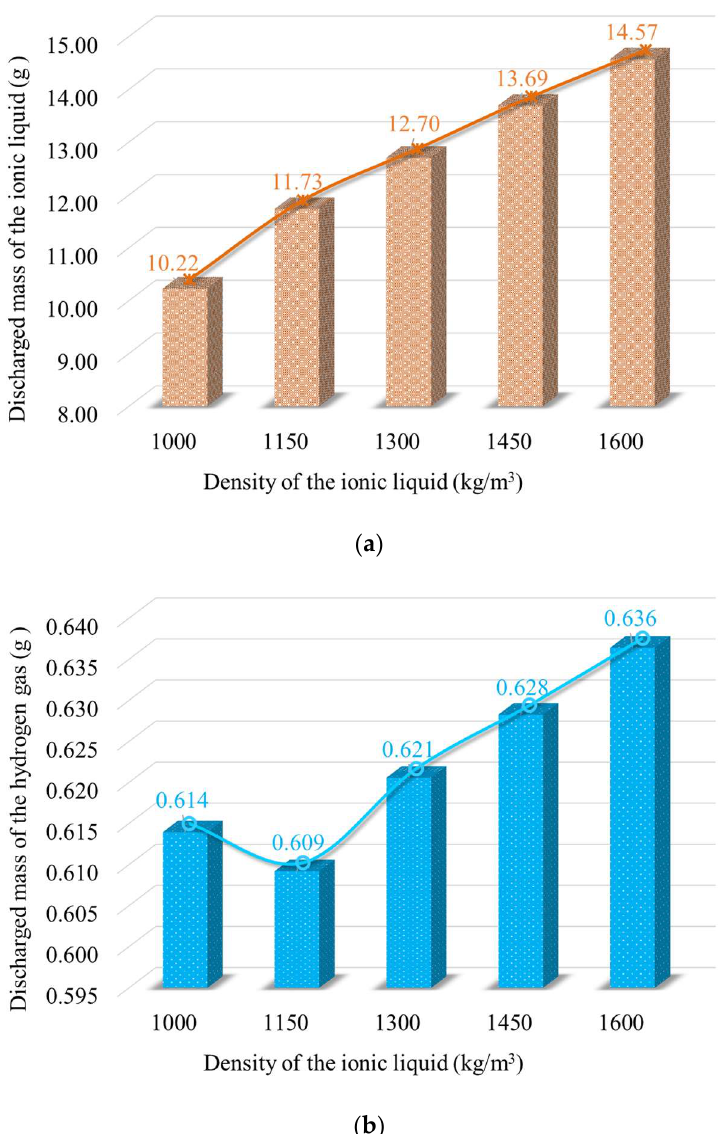
Figure 9. Mass transfer of ( a ) the ionic liquid and ( b ) hydrogen gas after one operation cycle. The total turbulent kinetic energy with different densities of the ionic liquid in one operation cycle is provided in Figure 10. The turbulent kinetic energy is the mean kinetic energy per unit mass associated with eddies in a turbulent flow, and the total turbulent kinetic energy is the turbulent kinetic energy multiplied by the total mass of the fluids. A decrease in the total turbulent kinetic energy was found from 0.000 to 0.025 s, while an elevation in it was found from 0.025 to 0.075 s in all simulation cases. From 0.075 to 0.160 s, a general reduction in the total turbulent kinetic energy was revealed with small fluctuations when it was close to 0.160 s. The largest peak value was found as 0.61 kJ with a liquid density of 1000 kg/m 3 , followed by the 0.60 kJ under the density of 1150 kg/m 3